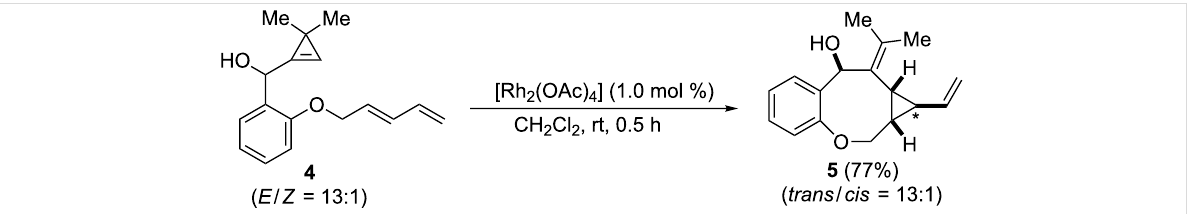
Scheme 4: Rh-catalyzed intramolecular cyclopropanation with dienylcyclopropene 4 (the trans / cis ratio is related to the C-atom labelled with an